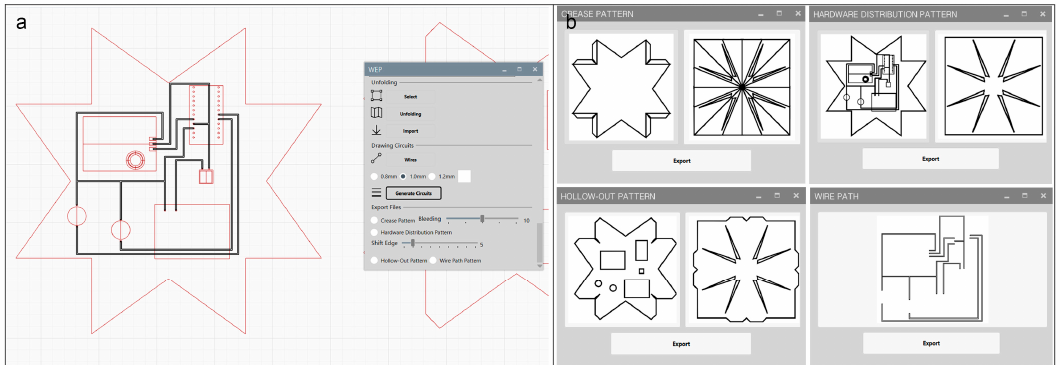
Figure 9. ( a ) Circuits drawing. Draw copper wires on the hardware distribution pattern and generate a new pattern; ( b ) Export files.